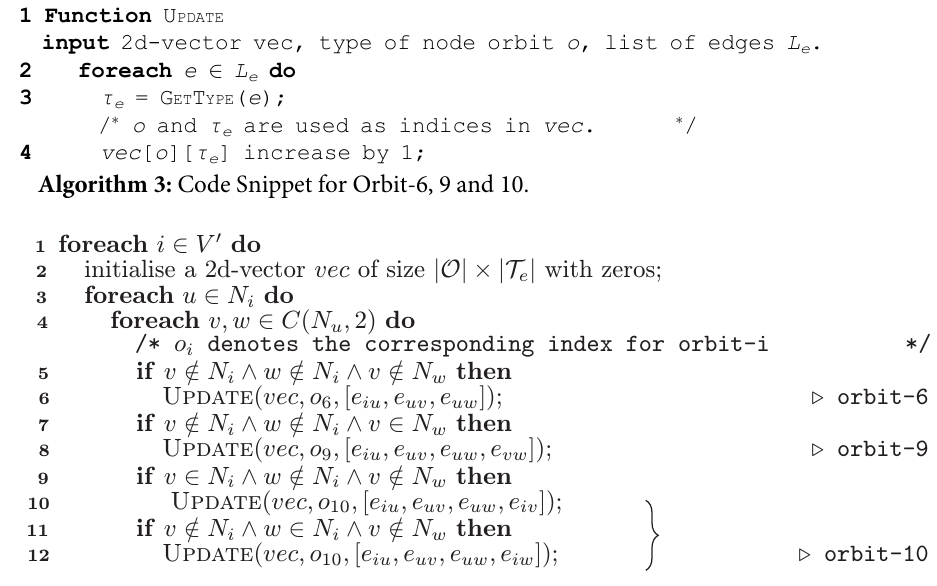
Algorithm 2: Update Vector.